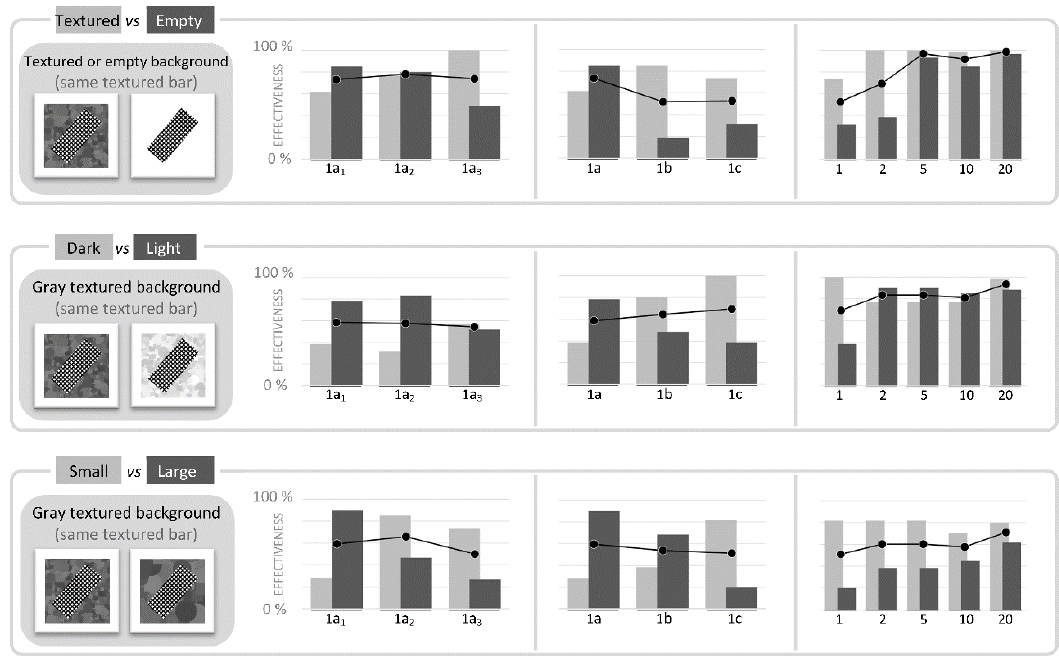
Figure 13. Second set of tests: comparison of performances with di ff erent image categories. To assess performances of HMAX in classification, in a second set of tests we compared in pairs di ff erent categories of BBID images, analogously to what was done in the pre-test. Thumbnails on the left-hand show a sample each category. Each category was composed by a complete battery of 60 images (10 orientations, and 6 sizes). Histograms show the e ff ectiveness of HMAX in each classification test: each pair of bars represents the number of items correctly classified in each category, in percentage. Di ff erent training conditions were tested. In «1a1-1a2-1a3» conditions, the HMAX was trained with only one image as representative of each class, and the same couples of images were repeatedly used in the three tests (i.e., the three tests were performed in the same conditions). In «1a-1b-1c» conditions, the HMAX was trained with one image for each category, but each test adopted a new and di ff erent couple of images. In «1-2-5-10-20» conditions, the HMAX was trained with a larger number of images (from 1 up to 20, per category), and new images were selected for each training. Class representative images were randomly selected. Black line with round markers shows the average values between categories.